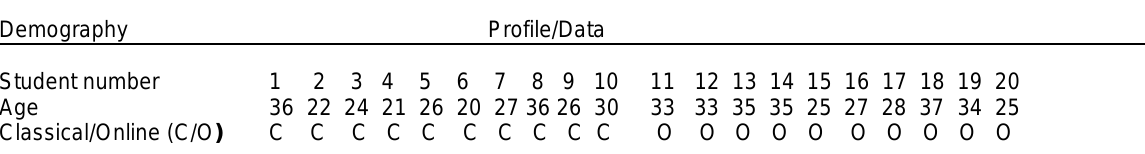
Profile of Classical (C) and Online (O) DE Learners